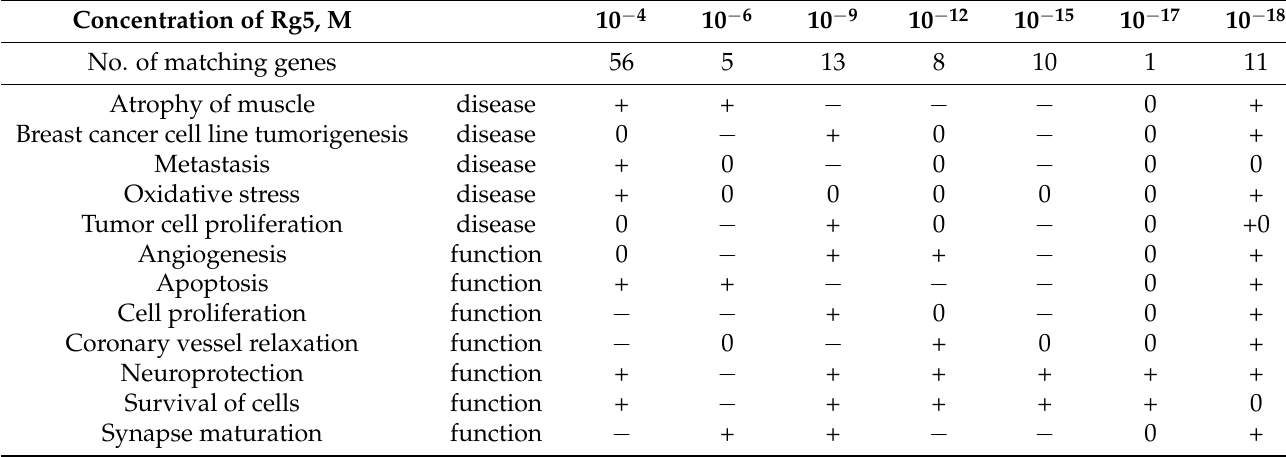
( − ) effects of Rg5 in various diseases and cellular functions associated with estrogen receptors signaling. Table 5. The number of genes matching estrogen receptors signaling pathway and predicted effects of Rg5 in various diseases and cellular functions associated with neurotransmission 1 . Concentration of Rg5,